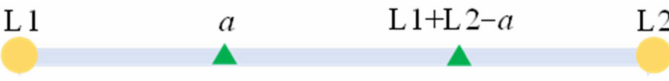
Figure 14. Reverse